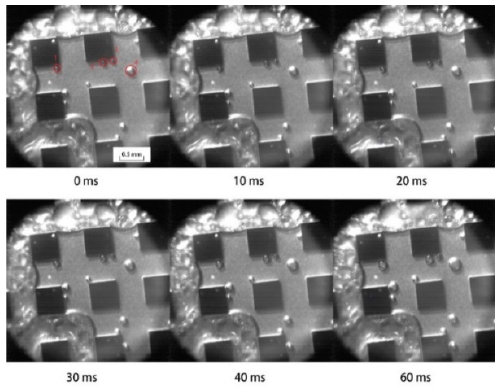
Figure 14. The process of bubble generation [76].